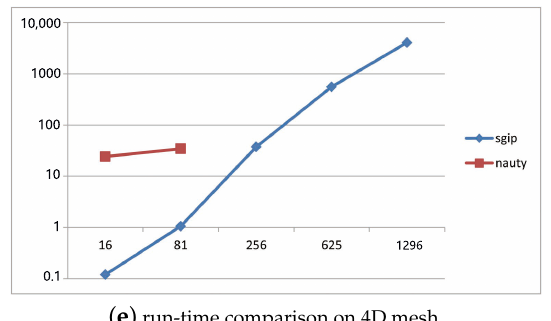
Figure 2. Performance comparison of sgip and nauty on different types of graph. Each experiment was tested on 100 couples of isomorphic graphs. ( a , b ) Horizontal axis represents the density of tested graphs (density is the ratio of the number of existing directed edges and n ( n − 1 ) ), vertical axis represents the running time of the responding tool. ( c , d , e ) Horizontal axis represents the number of vertices of the tested graphs, and the vertical axis is run-time on mesh graphs.